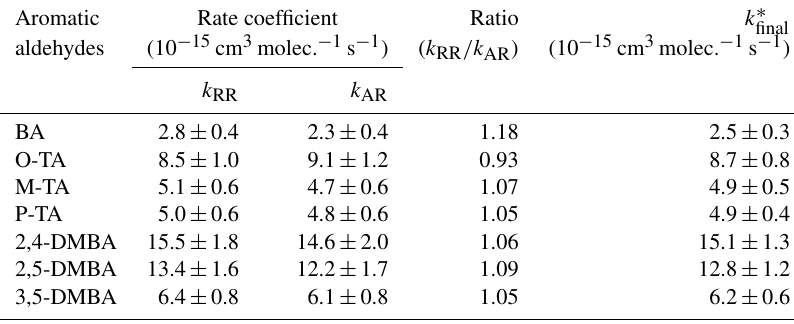
Table 1. Rate coefficients k 1 – k 7 measured in the study using two different methods. Aromatic